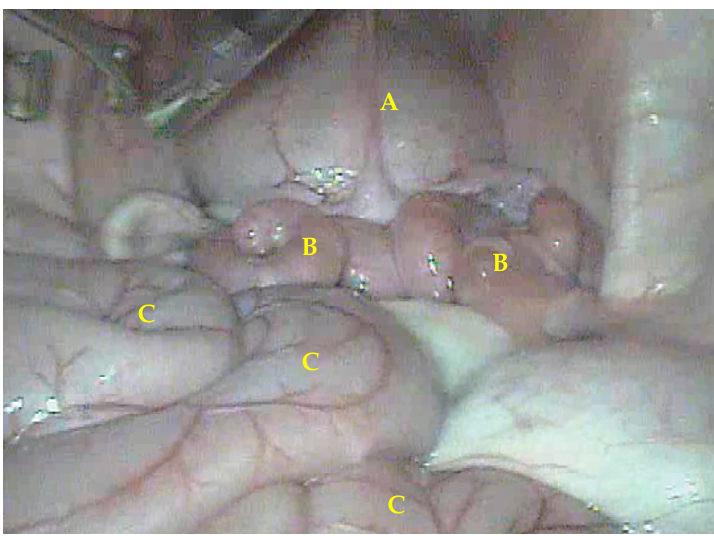
Figure 5. Videolaparoscopic image of the inguinal region of a buffalo heifer undergoing LOPU. Topographic location (craniocaudal view) of uterus (B), cranial to bladder (A); intestines appear in foreground (C).